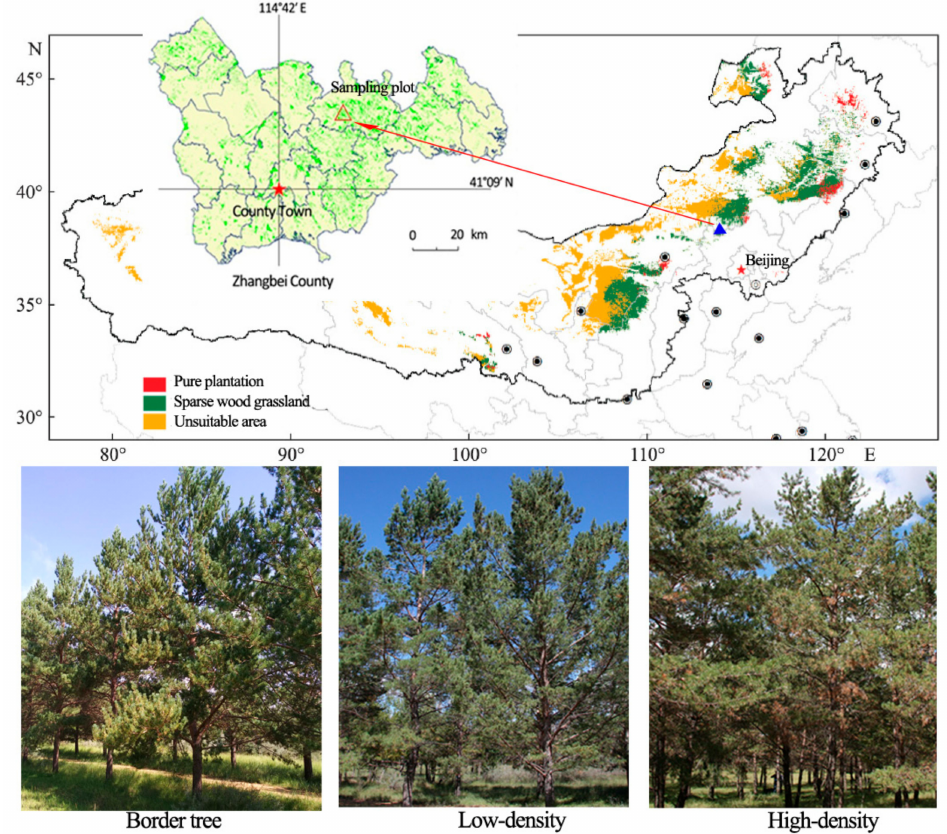
Figure 1. Classification of a ff orestation for Mongolian pine in sandy land in the construction regions of the Three-North Shelter Forest. Location, elevation, and climate of the experimental site in Zhangbei County, Hebei Province, China. Triangle: sampling plot for analysis of tree rings; red star: Zhangbei